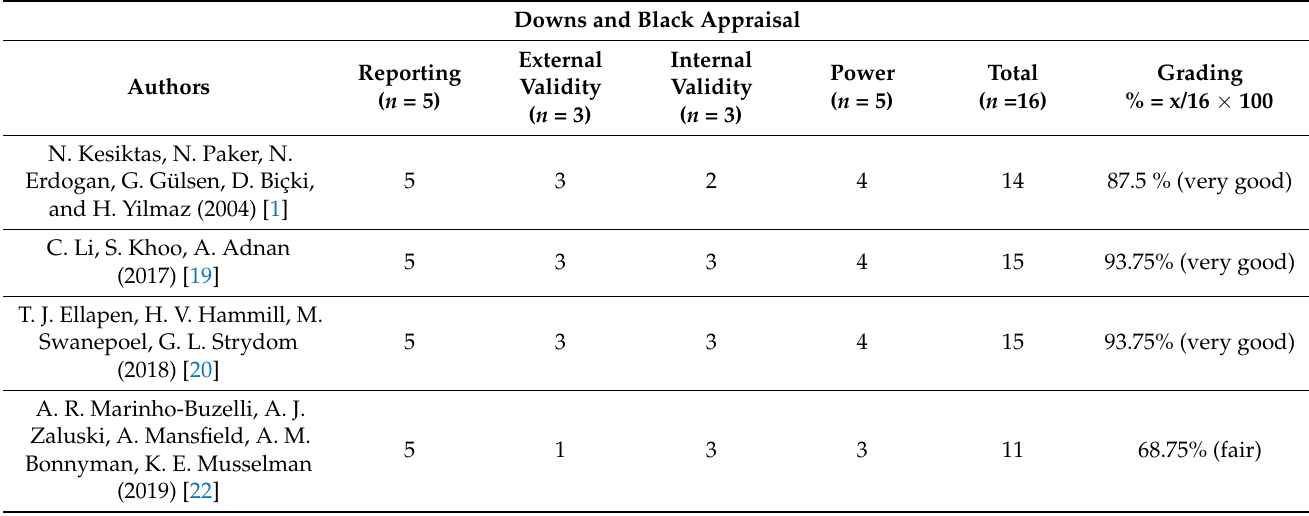
Table 1. Appraisal of records according to the modified Downs and Black Appraisal Scale. Downs and Black